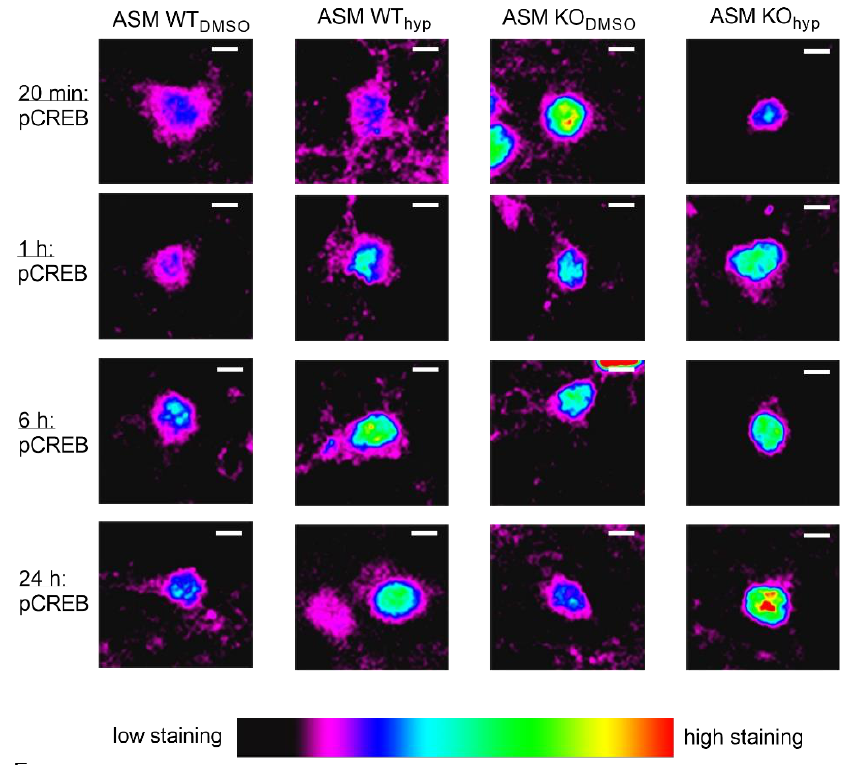
Figure 8. Genetic ASM deficiency impacts hyperforin-induced CREB-phosphorylation in inhibitory primary murine neuronal cells. ( A ). 24 h after hyperforin (1 µM) stimulation, ASM KO inhibitory neurons showed a significant increase in pCREB staining, ASM WT neurons a trend towards an increase. ( B ). After a 20 min treatment, ASM WT neurons showed a small positive trend towards stronger pCREB staining, and ASM KO neurons contrarily showed significantly decreased pCREB levels. ( C ). 1 h after hyperforin application, no treatment or genotype-induced effects were observed. ( D ). 6 h after hyperforin stimulation, no treatment or genotype-induced effects were observed. ( E ). Representative images of pCREB staining in single nuclei of excitatory murine neurons after indicated treatments and time points. Scale bar indicates 5 µm. Bars indicate mean ± SEM; n = 2 cell batches, 1 cover slip analyzed per batch, 3–7 regions analyzed per cover slip; * p ≤ 0.05, *** p ≤ 0.001.